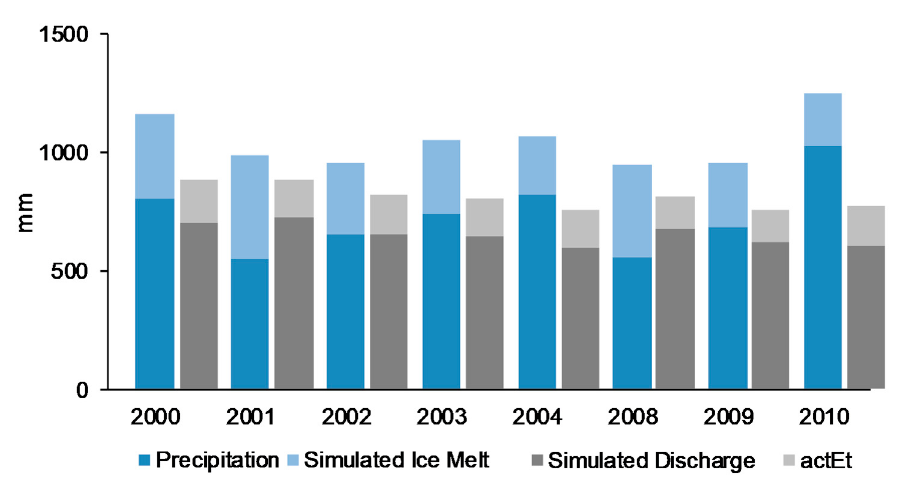
Figure 8. Annual water balance components in the Hunza river basin during the modeling period.